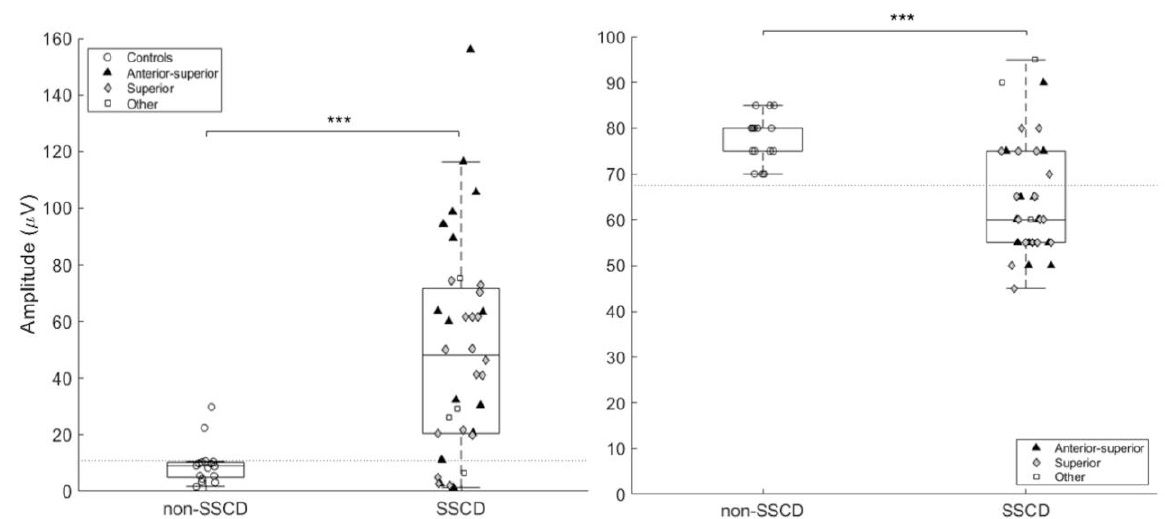
Figure 5. Boxplot and scatter of oVEMP amplitude ( A ) and oVEMP threshold ( B ) for both groups. The dotted line represents the proposed cutoff. *** p ≤ 0 .0001.